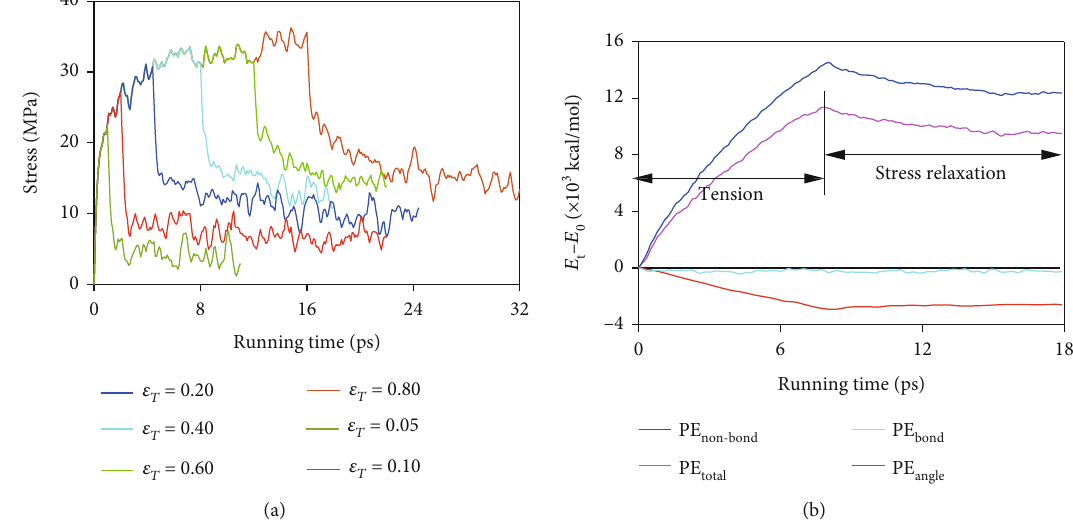
Figure 10: Evolutions of (a) stress with the relaxation time at di ff erent strains of relaxation and (b) potential energy with the relaxation time at the strain of relaxation of